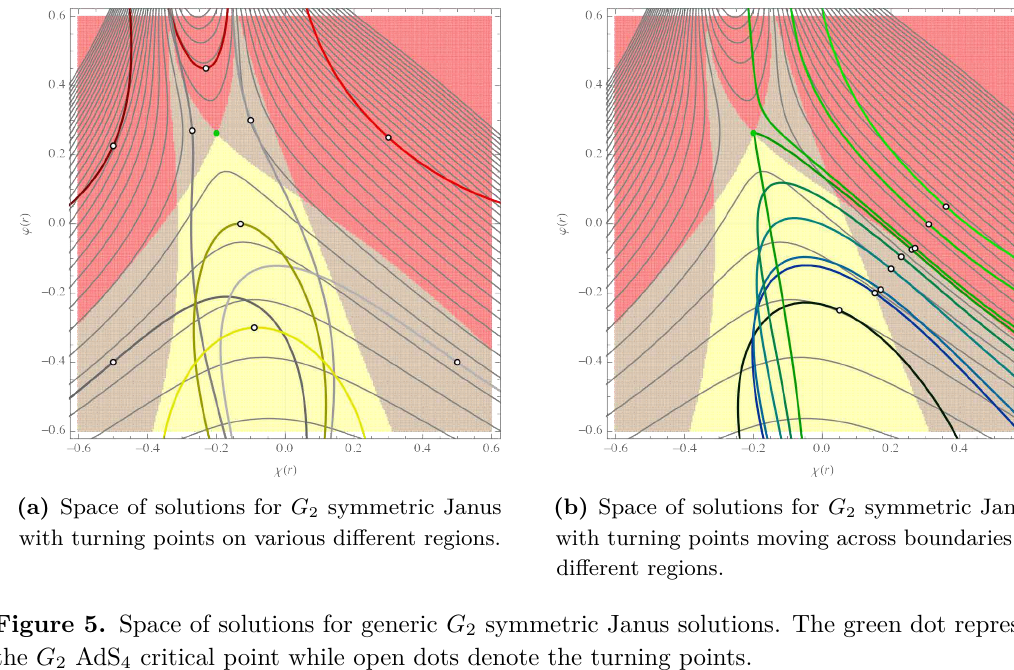
Figure 5. Space of solutions for generic G 2 symmetric Janus solutions. The green dot represents the G 2 AdS 4 critical point while open dots denote the turning points.